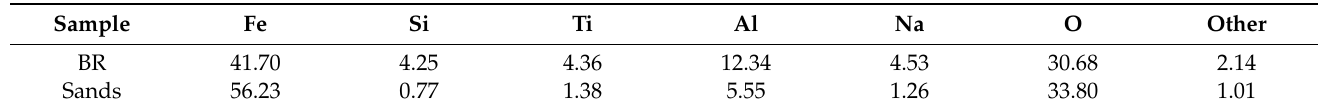
Table 1. The chemical compositions of bauxite residue (BR) and sands from the Friguia alumina refinery, Guinea, wt.%.